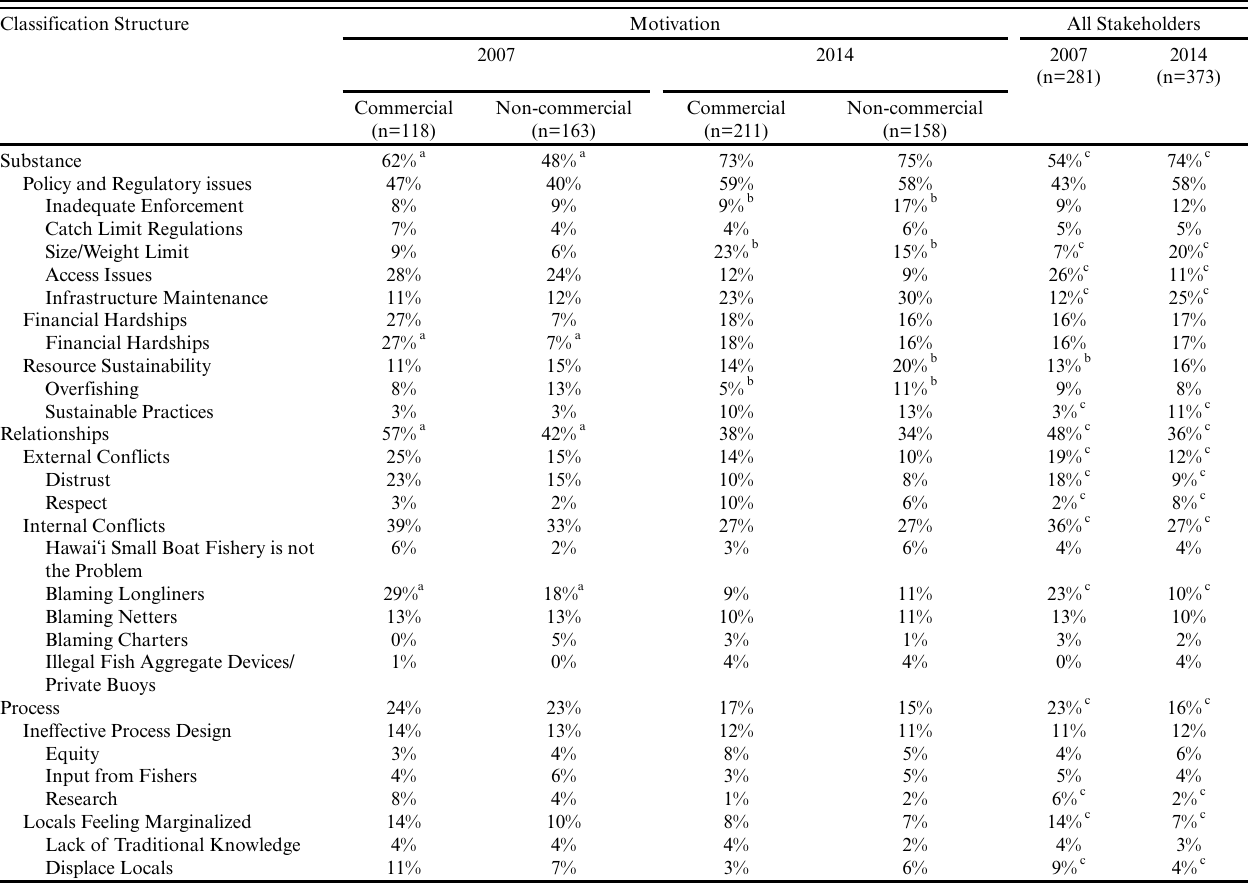
Table 4 . Percentage of respondents mentioning that code over total number of respondents for that group. a indicates a statistically significant difference (p < 0.05) between commercial and non-commercial fishers in 2007; b indicates a statistically significant difference (p < 0.05) between commercial and non-commercial fishers in 2014; c indicates a statistically significant difference (p < 0.05) between all stakeholders in 2007 and